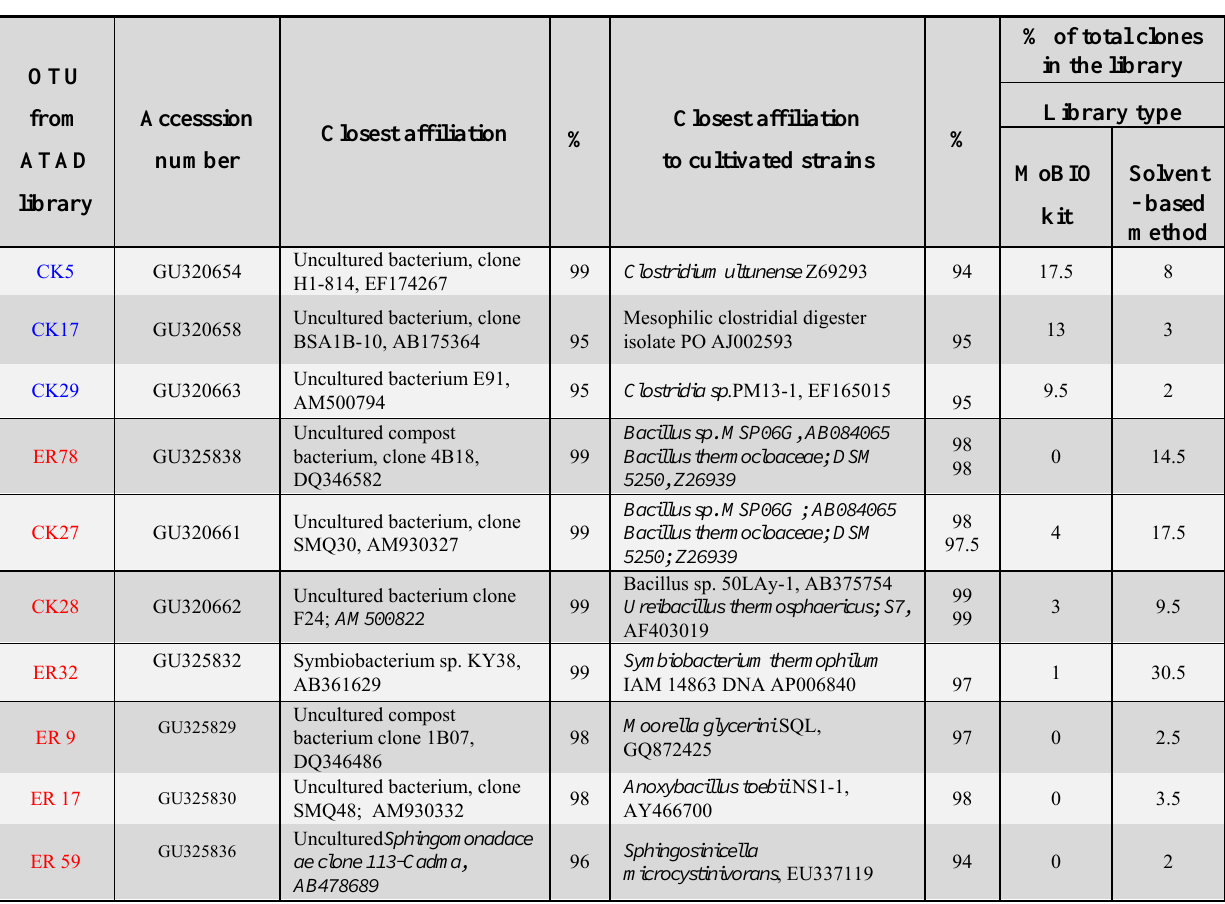
Table 2. Taxonomic affiliation of predominant and unique clones within the clone libraries constructed with ATAD DNA extracts obtained by two different DNA extraction